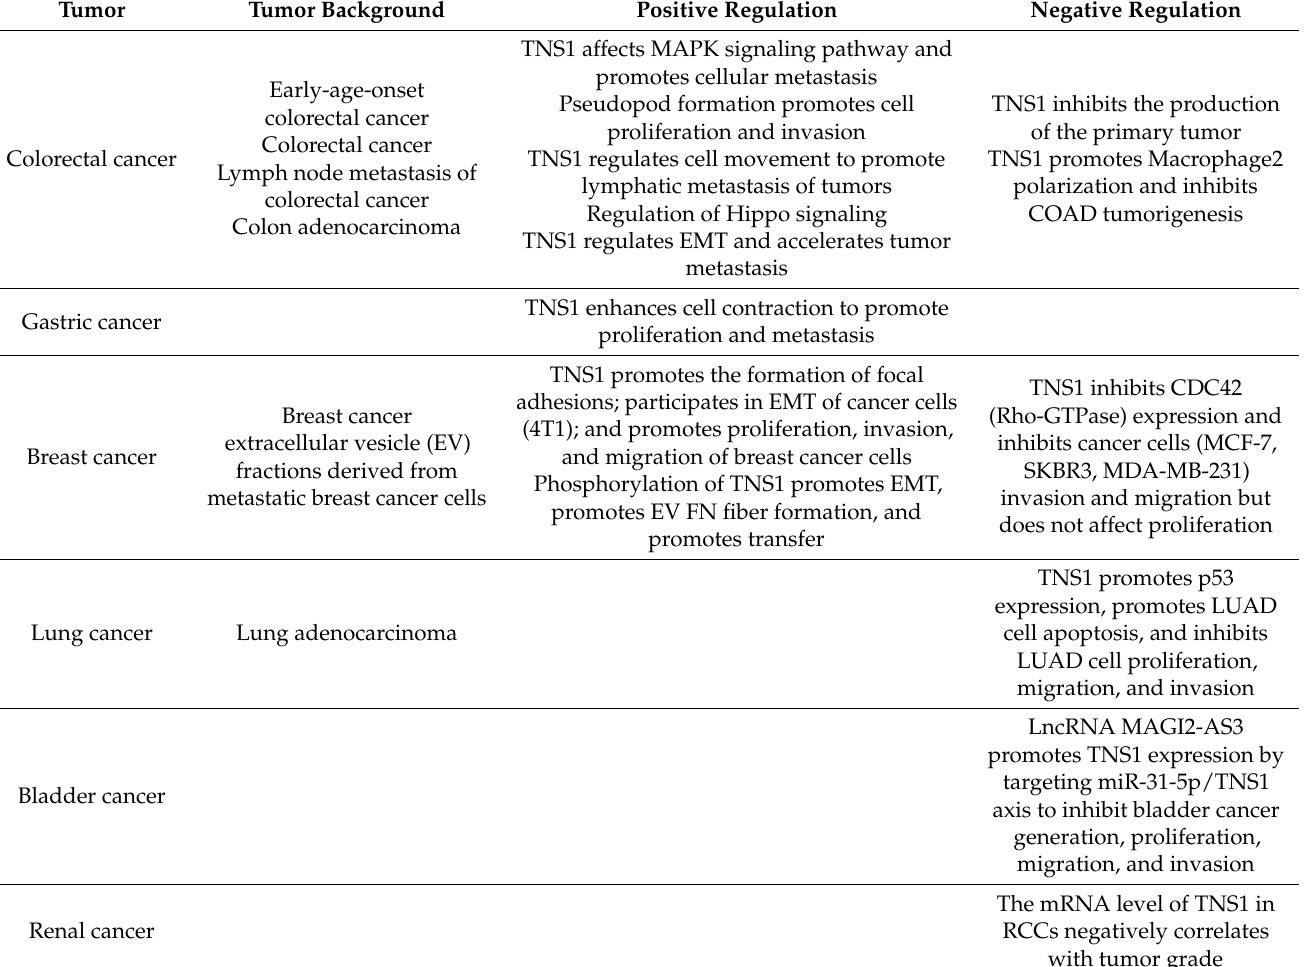
Table 1. Positive and negative regulatory mechanisms of TNS1 in different